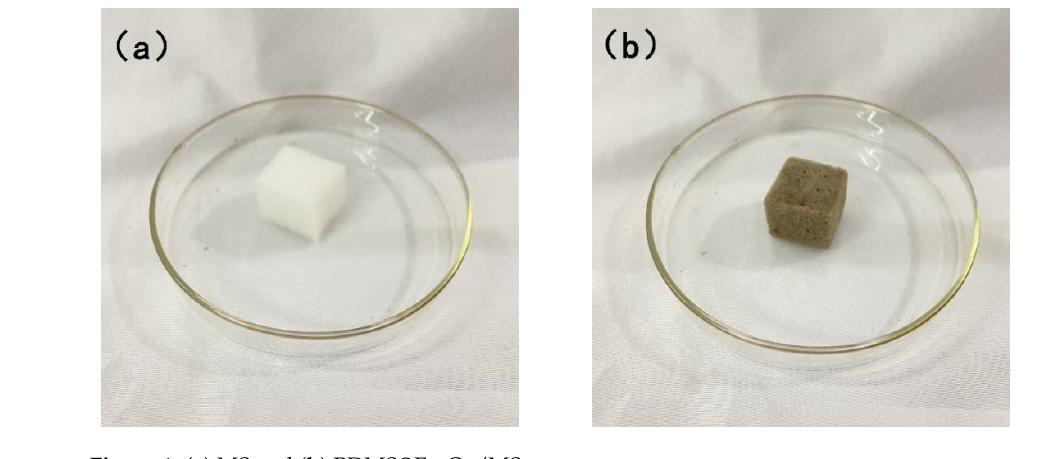
Figure 1. ( a ) MS and ( b ) PDMS@Fe 3 O 4 /MS.